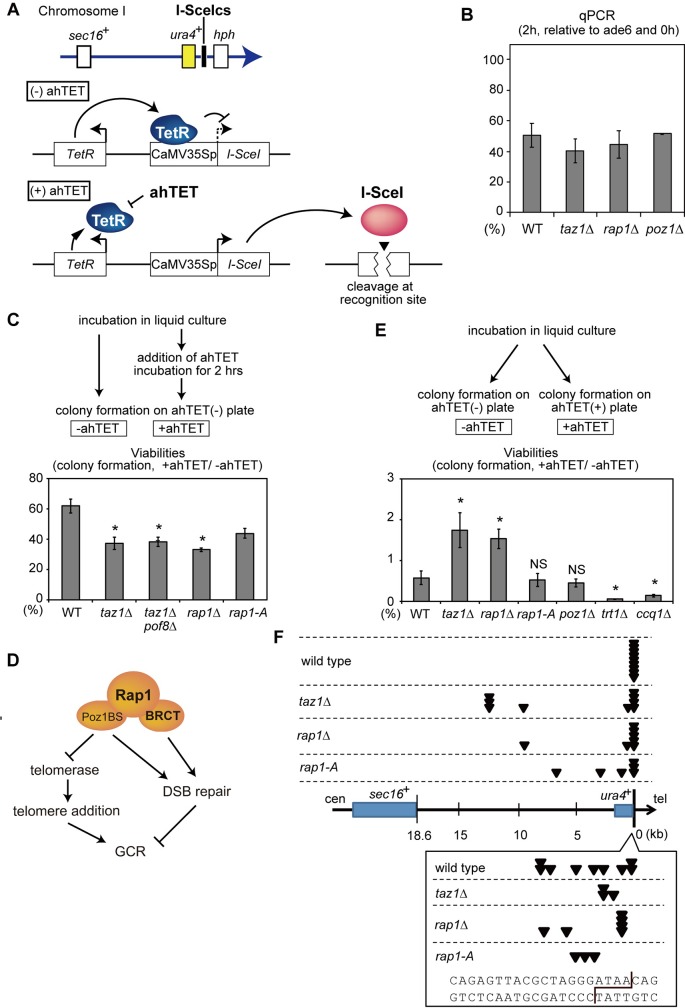
Taz1 and Rap1 are involved in the repair of I-SceI-induced DSBs.(A) Schematic of our site-specific DSB induction system. A gene that encodes endonuclease I-SceI was placed under a modified CaMV 35S promoter that can be repressed by the Tet repressor (TetR) [67]. I-SceIcs was inserted at the same site as the marker gene cassette in the ura4-TK strain. A DSB at I-SceIcs can be induced by TetR inhibition via ahTET treatment. (B) Efficiency of DSB induction in I-SceIcs. At the indicated time points after addition of ahTET, DNA breaks were monitored by qPCR with a primer set flanking I-SceIcs. (C) Frequencies of colony-forming cells on non-selective agar plates with or without ahTET treatment for 2 hours. Asterisks represent significant differences (P < 0.05) from the wild-type strain. P-values were obtained by the two-tailed Student’s t-test. We found that I-SceI digestion proceeded for additional two hours ahTET washout (S6A Fig), likely due to residual I-SceI activity remaining after the expression shut-down. Therefore, the digestion efficiencies were likely even greater than the 40~50% indicated in (B). (D) Current model of how Rap1 functions in DSB repair and GCR suppression. See text for details. (E) Survival rates determined by counting numbers of colonies formed on ahTET-containing and non-selective agar plates. (F) Locations of the GCR junctions in the survivors isolated in (E). All survivors were examined for GCR structures as in Fig 1C and 1E. All clones had chromosomal terminal deletions, and none of them displayed translocations. We could not identify the GCR type and location of the junction in one out of the ten examined survivors in both the WT and taz1Δ strains. Each triangle (arrowhead) represents the location of the GCR junctions. The inset shows the sequences around I-SceIcs. The cleavage pattern of I-SceI is shown with a line. Regarding (B), (C), and (E), mean values ± SEM are shown. N = 3.